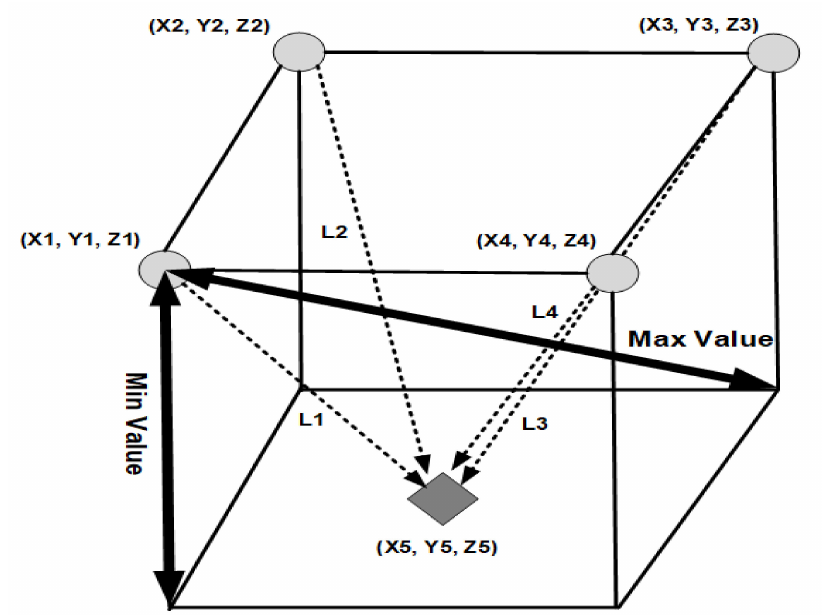
Figure 3. Measure integrity synchronization of IoT data using AIoT location